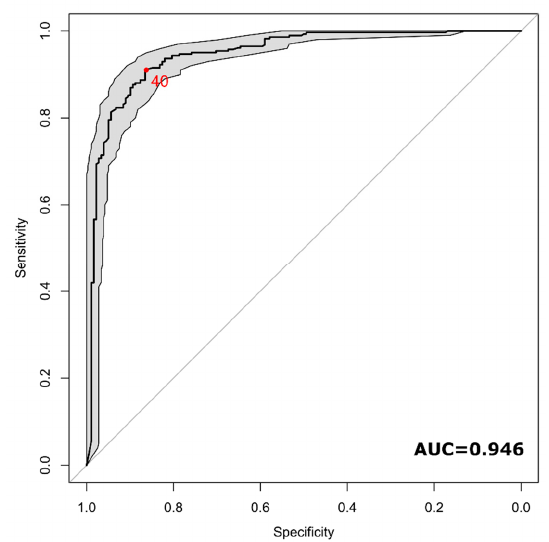
Figure 7. ROC curve of the diagnostic performance of central vein sign in T2*-based images for differentiating MS from other mimicking diseases at an individual level. The red dot indicates the optimal cut-off identified (40%).